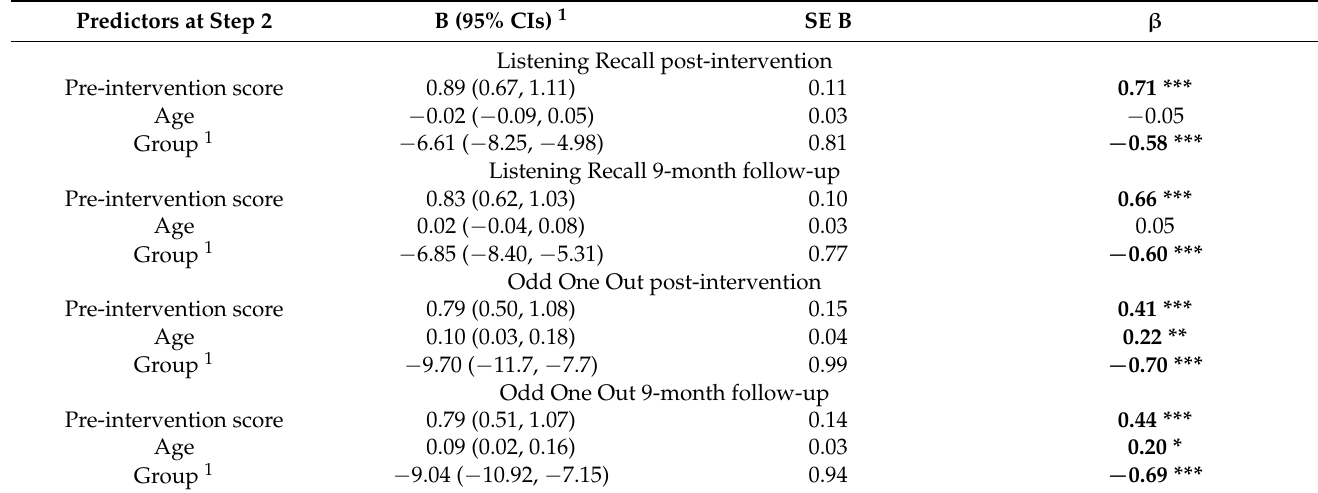
Table 3. Summary of step 2 of the regressions for the outcome variables Listening Recall and Odd One Out (assessing the direct effects of the training